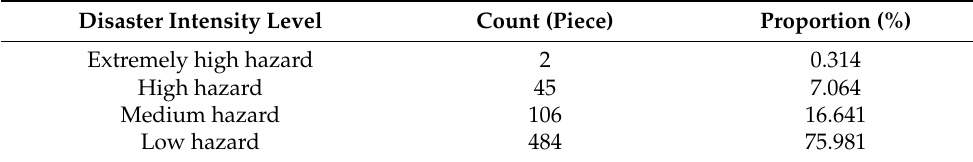
Table 4. Statistical table of geological disaster intensity level.